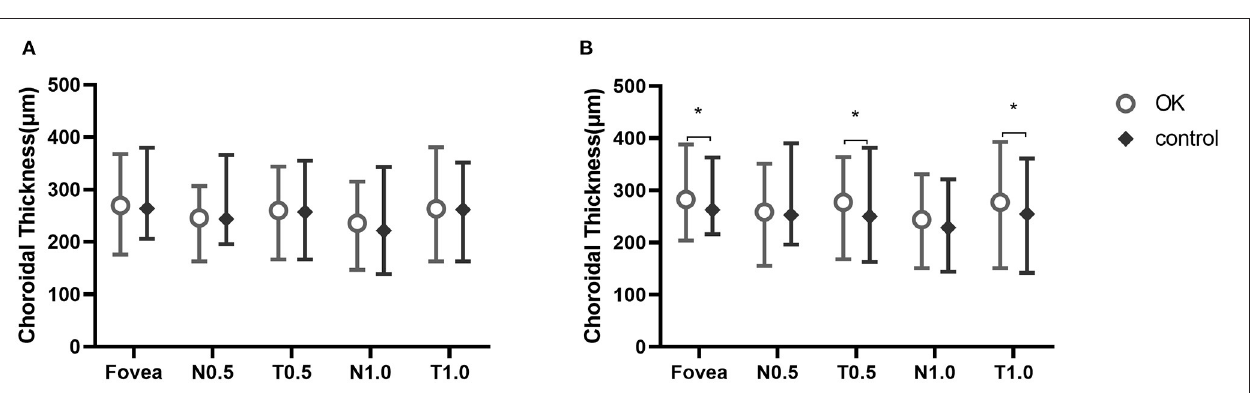
FIGURE 3 | Choroidal thickness at five measurement points at baseline (A) and at 6 months (B) . * Statistically